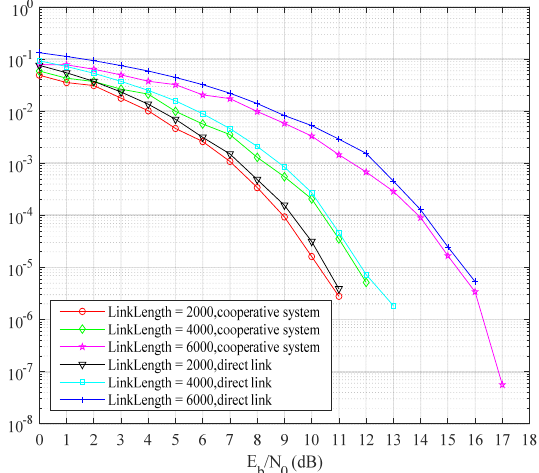
Figure 4. BER of cooperative FSO communication system and direct link under different communication distances.